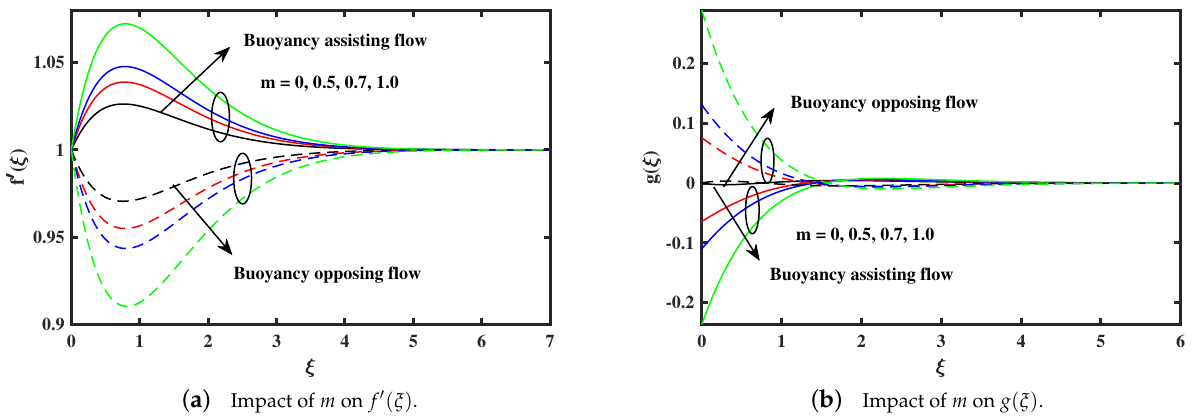
Figure 3. Fluctuation of f (cid:48) ( ξ ) and g ( ξ ) against microrotation concentration ( m ).